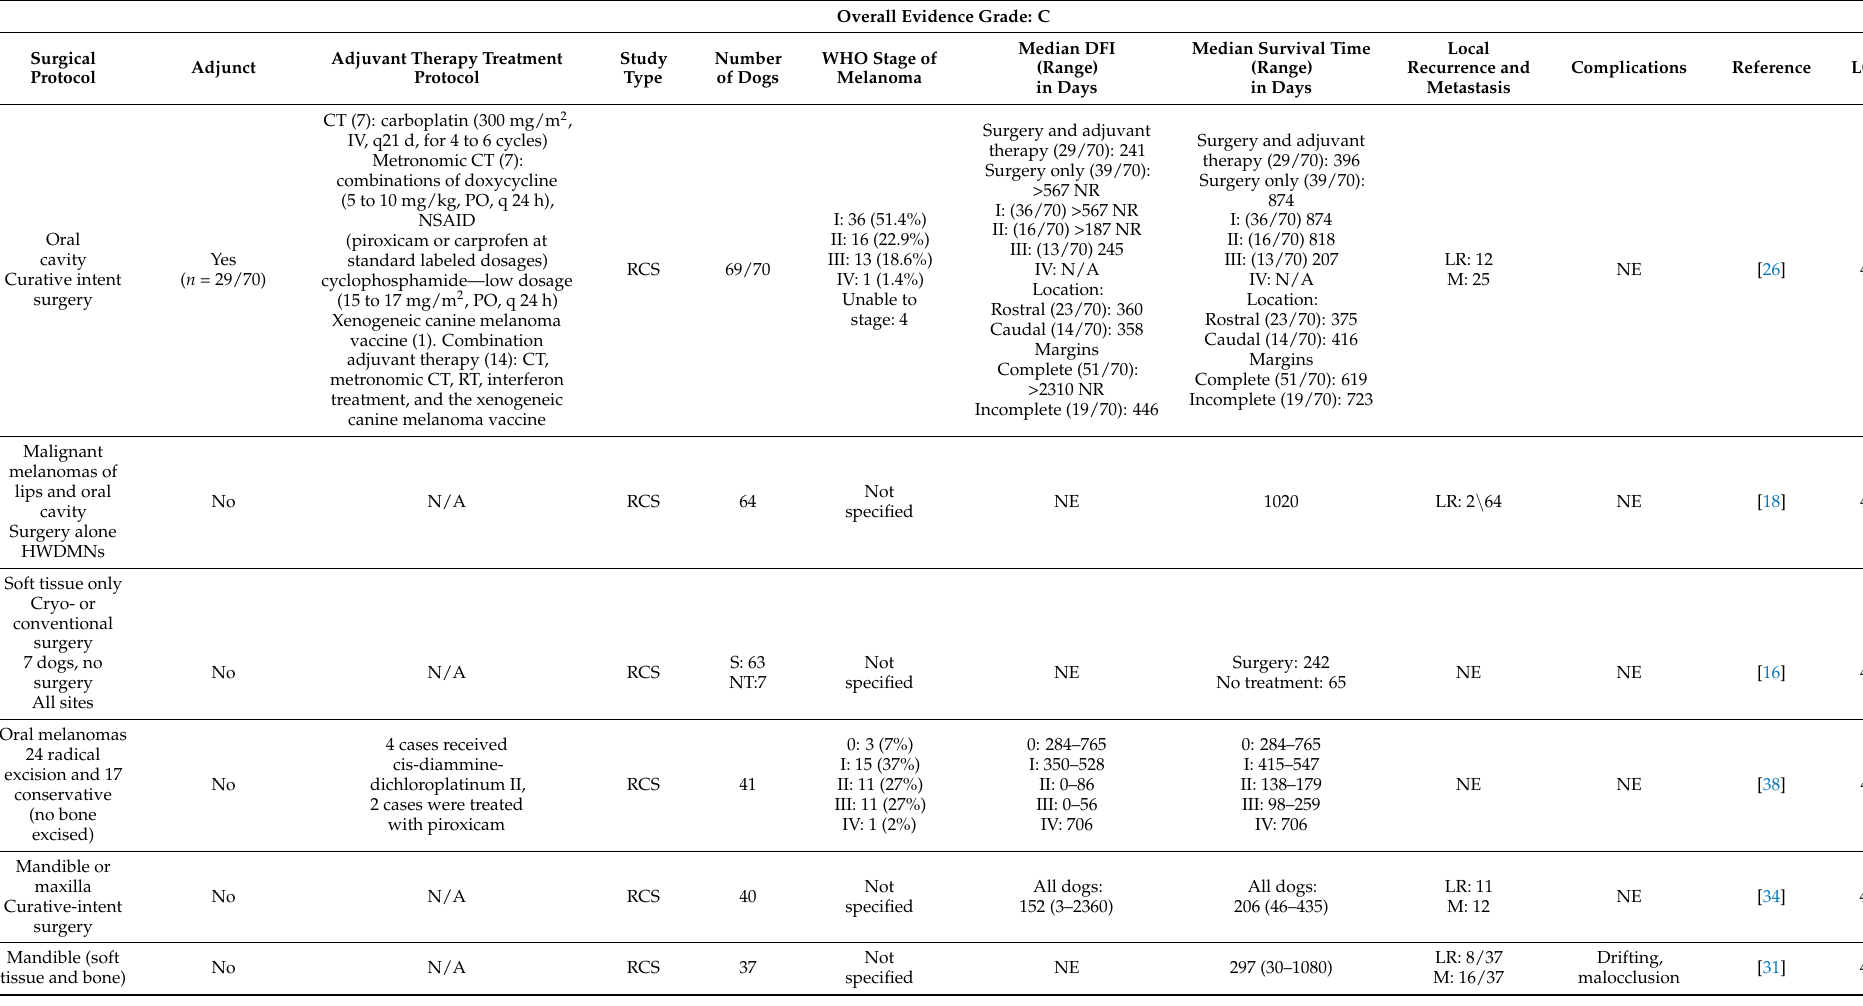
Table 2. Summary of surgical studies evaluating effectivity in oral malignant